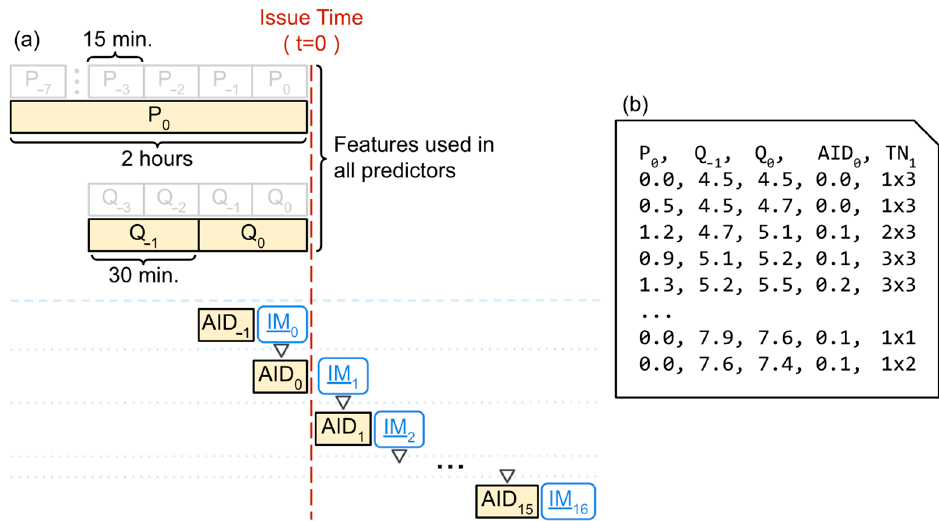
Figure 3. Organization of the phase space used as input for the NARX. In the scheme ( a ), data in the state space (light grey boxes) are aggregated and used as predictive features (yellow boxes) in different combinations to predict IMs (blue rounded-corner boxes). In the output file ( b ), the first four columns ( P 0 , Q − 1 , Q 1 , AID 0 ) are the predictors and the last is the target ( TN 1